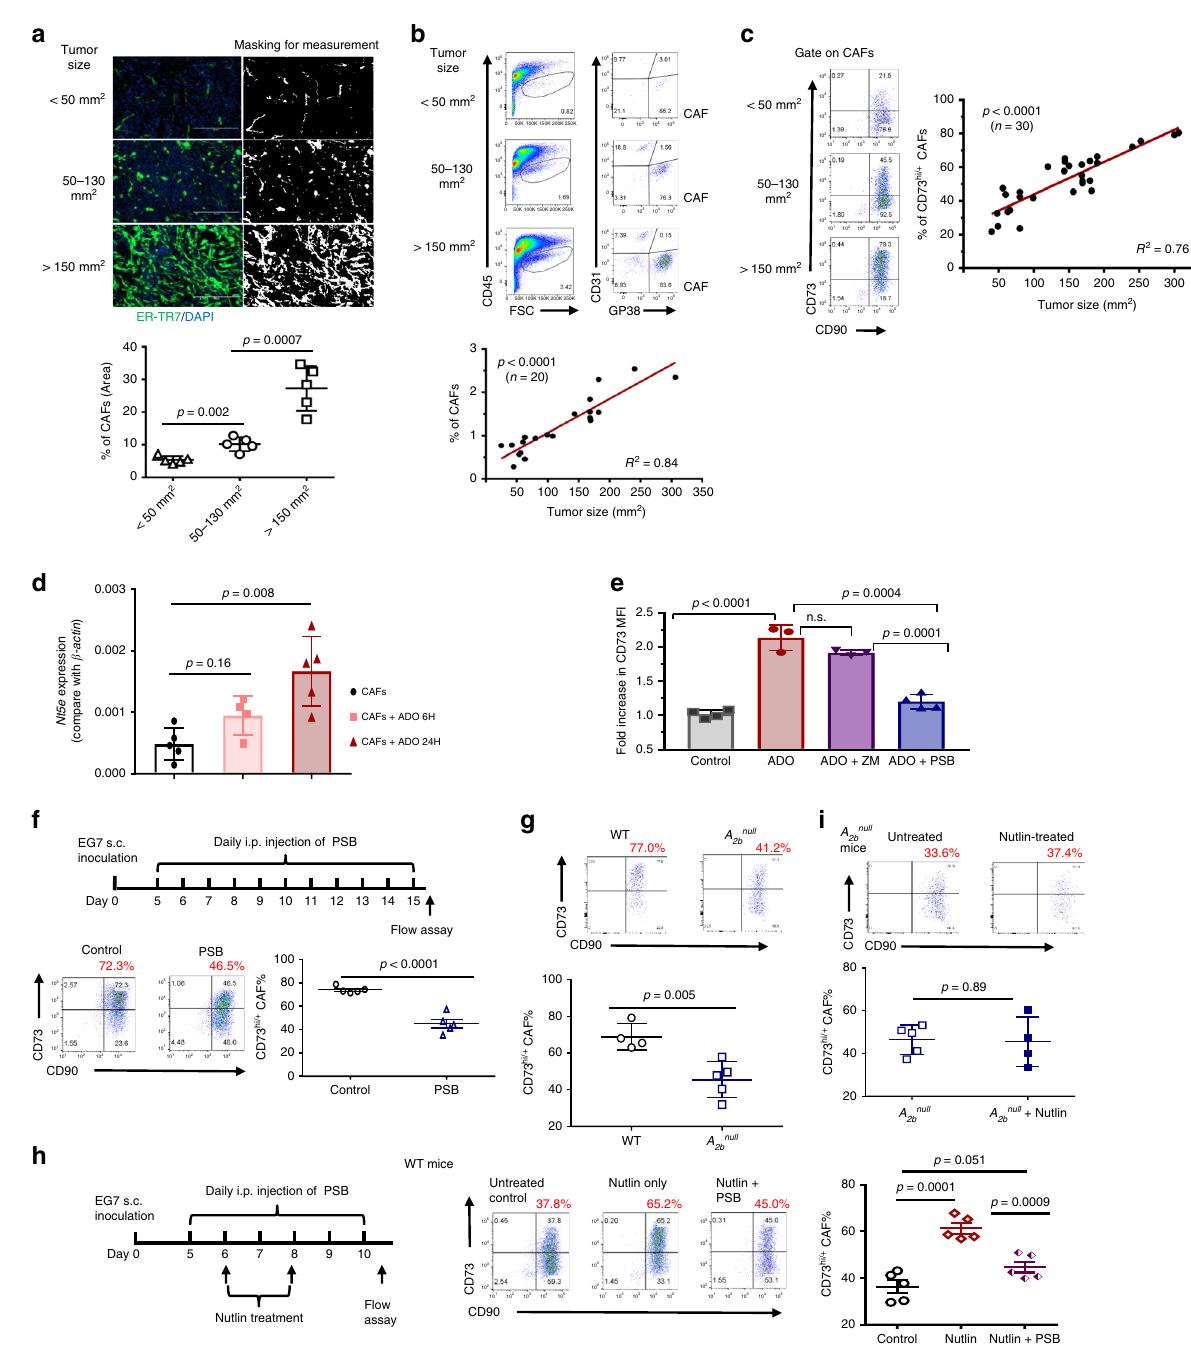
Fig. 5 CAF-CD73 expression is dynamically upregulated via the ADO-A 2B pathway. a The relative abundancy and distribution of CAFs in EG7 tumors of various sizes were evaluated via ER-TR7 (green) staining using a computer-assisted software, MetaMorph. Data depict mean ± SEM. b , c The CAF abundancy and CAF-CD73 levels in EG7 of various sizes were analyzed via FACS. d EG7-CAFs were treated with 100 μ M ADO for 6 and 24 h and their Nt5e ( Cd73) expression was determined via quantitative real-time RT-PCR. e EG7-CAFs were treated with 100 μ M ADO in the absence or presence of A 2A or A 2B antagonists, ZM241385 or PSB1115, respectively. Relative CD73 expression on CAFs was determined via FACS. f EG7 tumor-bearing WT mice were treated with daily i.p. injection of 1 mg kg − 1 body weight of PSB1115 or vehicle (DMSO) as a control. CD73 expression on CAFs were examined via FACS. g WT and A 2b null mice were inoculated with EG7 tumors and their CAF-CD73 expression from tumors of similar sizes was compared. h EG7 tumor-bearing WT mice were treated with daily i.p. injection of 1 mg kg − 1 body weight of PSB1115 or vehicle starting from 5-day post-tumor inoculation followed with i.t. injections of 100 μ l of 20 μ M nutlin at days 6 and 8. i EG7 tumor-bearing A 2b null mice were treated with i.t. injections of 100 μ l of 20 μ M nutlin at days 6 and 8 post-tumor establishment. CD73 expression on CAFs from WT h and A 2b null i mice were analyzed via FACS and compared to those without nultin- treatment ( n = 5). Error bars depict mean ± SEM. p values were determined via two-tail unpaired Student ’ s t -test a , d – i . Linear regression analysis was performed to determine the correlation between the tumor size and CAF% or CD73 + CAF% in b , c , respectively. All experiments were repeated at least two times. Source data are provided in the Source Data fi